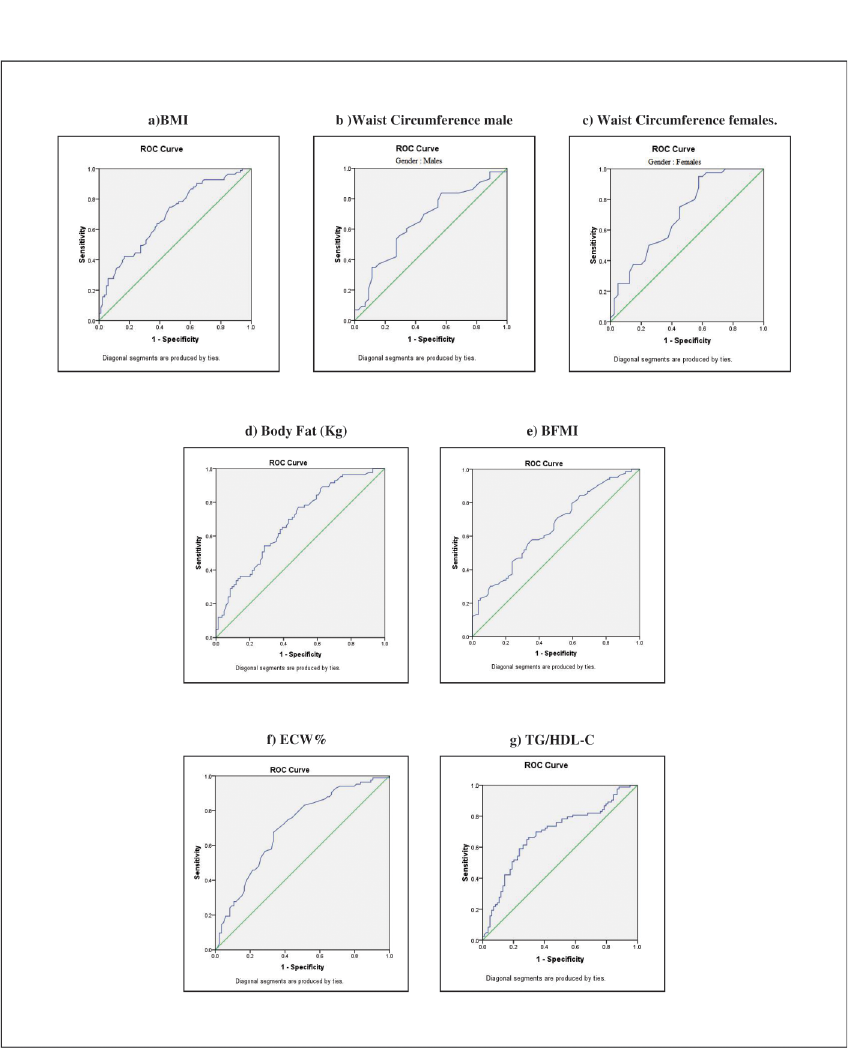
Fig 1. ROC curves of BMI, WC, Body Fat (Kg), BFMI, ECW% and TG/HDL as predictors of prediabetes.